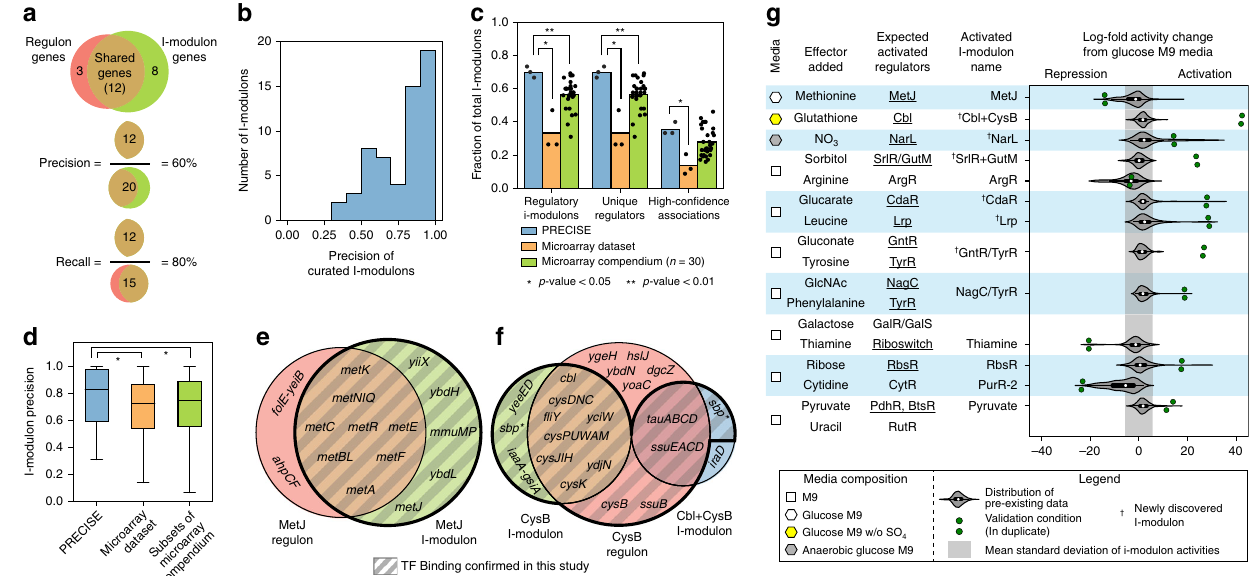
Fig. 2 Validation of I-modulon – Regulator relationships. a Precision is the fraction of genes in an i-modulon that are in the linked regulon, and recall is the fraction of genes in a regulon that are in the linked i-modulon. b Precision across all 61 regulatory i-modulons. c Fraction of total i-modulons signi fi cantly enriched with targets from a single transcriptional regulator. I-modulons generated from PRECISE (blue) were compared against i-modulons generated from a microarray dataset with 266 expression pro fi les 26 (orange), and i-modulons generated from 10 similar-sized subsets of a single-platform microarray compendium 10 (green). Each dataset was analyzed using three-fold cross-validation (see the “ Methods ” section), resulting in 30 data points for the microarray compendium. Single star represents a Mann – Whitney U -test p -value < 0.05, and double star represents a p -value < 0.01. d Boxplots comparing the precision of regulatory i-modulons across all three datasets. Single star represents a Mann – Whitney U -test p -value < 0.05. Boxplot whiskers represent extrema of data, box bounds represent upper and lower quartiles, and center-line represents the median value. e Comparison of genes in the MetJ regulon (red) and i-modulon (green). Genes validated by ChIP-exo are in the shaded regions. Gene names for co-transcribed genes were combined (e.g. metBL represents the transcription unit containing metB and metL ) ( f ) Comparison of genes in the CysB regulon (red) and the CysB and Cbl + CysB i-modulons (green and blue, respectively). Most genes in the Cbl + CysB i-modulon were regulated by both Cbl and CysB. The starred gene, sbp , was a member of both i-modulons but was not in the reported CysB regulon. Genes with TF binding as determined by ChIP-exo are in the shaded regions. g Ten media for predicted i-modulon activations. Correctly activated i-modulons are underlined. Distribution of i-modulon activities from pre-existing data includes all data from PRECISE excluding the 10 validation conditions. The gray shaded region represents the average standard deviation across pre-existing i-modulon activities. All amino acid supplements were L -form, and all sugars were D -form. Abbreviations: GlcNAc